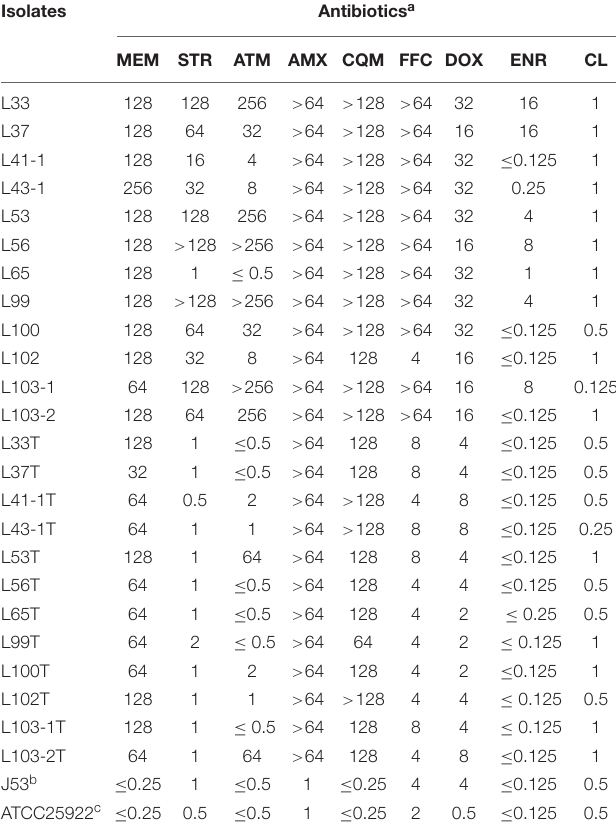
TABLE 1 | Antibiotic susceptibility profiles of the carbapenem-resistant E. coli strains and the corresponding transconjugants to different antibiotics (mg/L).